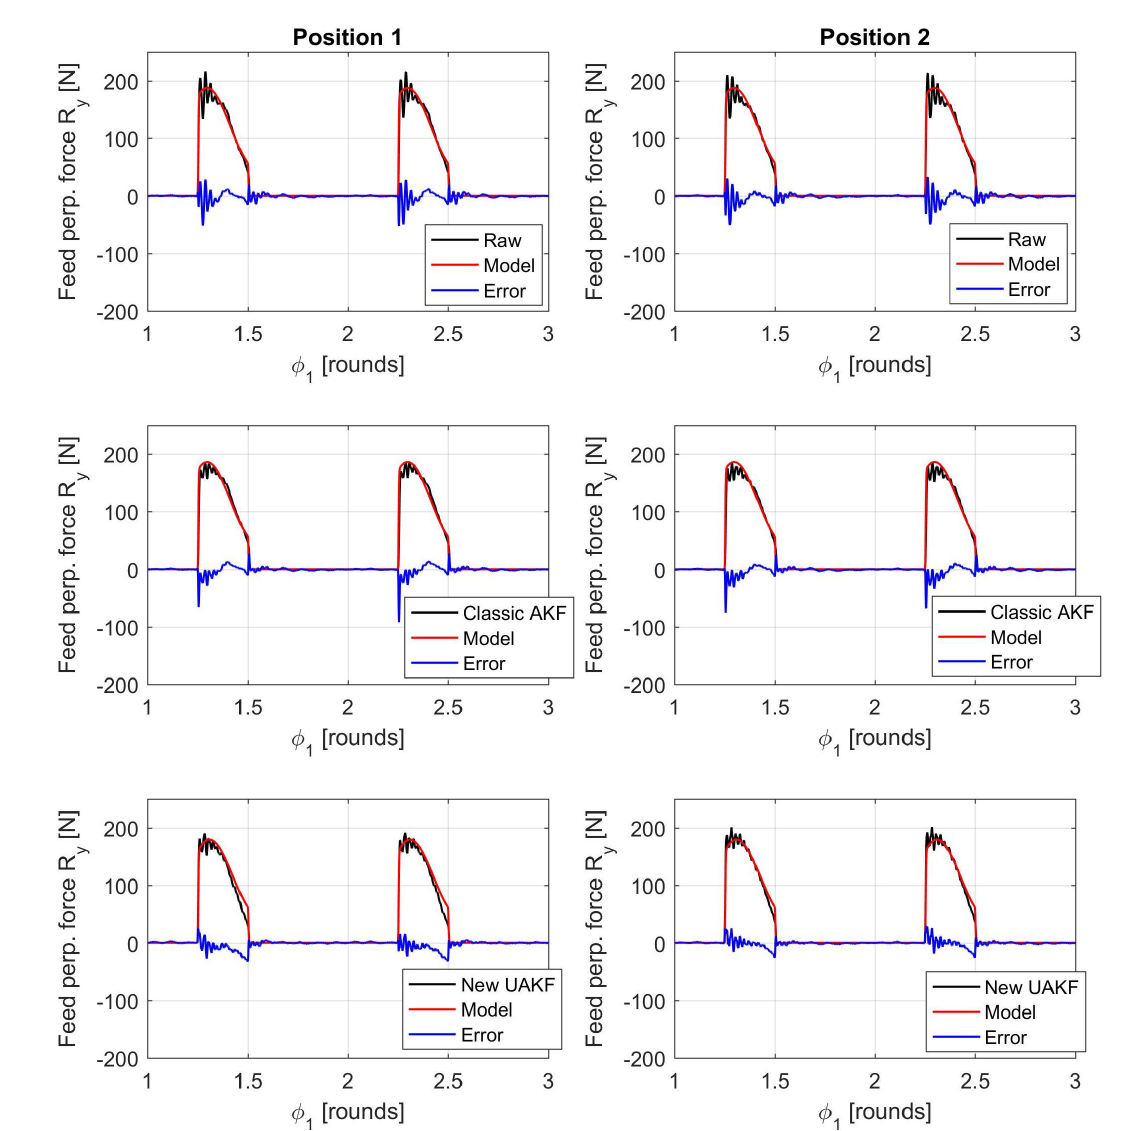
Figure 7. Comparison between filtered cutting forces and cutting force model along the feed perpendicular direction Y ( a p = 0.8 mm, f z = 0.14 mm). The two subfigures in the middle show the filtered cutting forces obtained from the classical AKF that was based on both direct and cross TFRFs. The two subfigures on the bottom show the filtered cutting forces obtained from the novel UAKF approach. Moreover, all subfigures on the left refer to position 1 (milling bass beginning) while all subfigures on the right refer to position 2 (milling pass